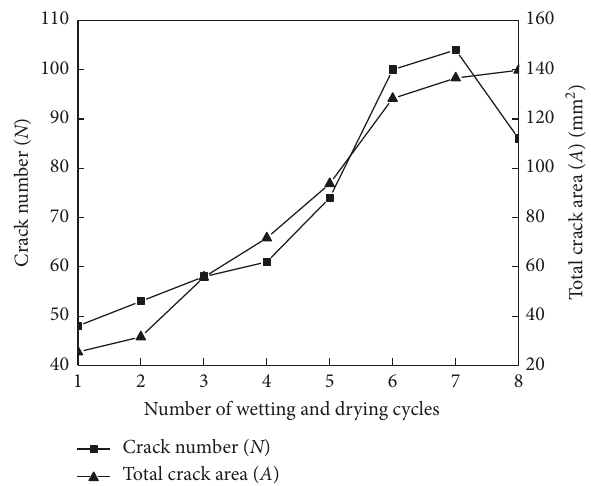
Figure 9: Curves of the crack number and total crack area.